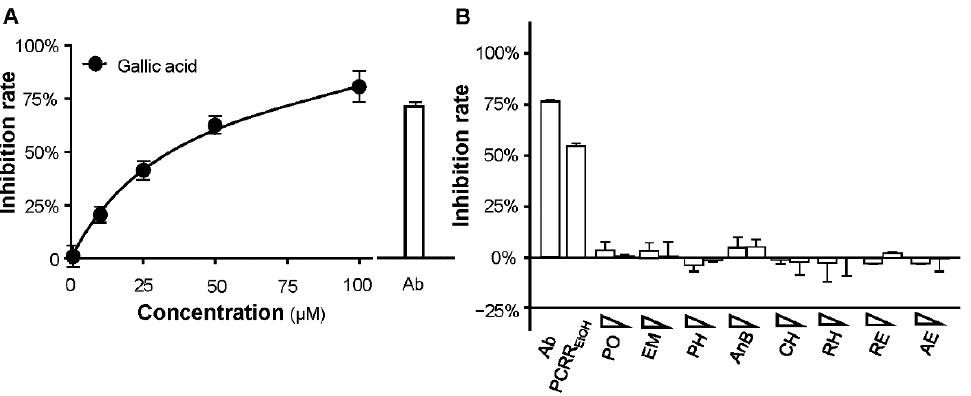
Figure 7. Gallic acid blocks entry of the pseudovirus into HEK293T cells. ( A ) Gallic acid displayed inhibition in a dose-dependent manner. ( B ) The other phytochemicals in PCRR showed a negligible inhibitory activity when tested at high and low concentrations. Ab: neutralizing antibody (used at 1 µg/mL); PCRR EtOH (used at 0.025 mg/mL); PO: polydatin (used at 50 µM [high], 0.5 µM [low]); EM: emodin (used at 25 µM, 0.25 µM); PH: physcion (used at 1 µM, 0.01 µM); AnB: anthraglycoside B (used at 100 µM, 1 µM); CH: chrysophonal (used at 5 µM, 0.05 µM); RH: rhein (used at 20 µM, 0.2 µM); RE: resveratrol (used at 22 µM, 0.22 µM); AE: aloe emodin (used at 100 µM and 1 µM). All of the data are shown as mean ± SD; n = 3.